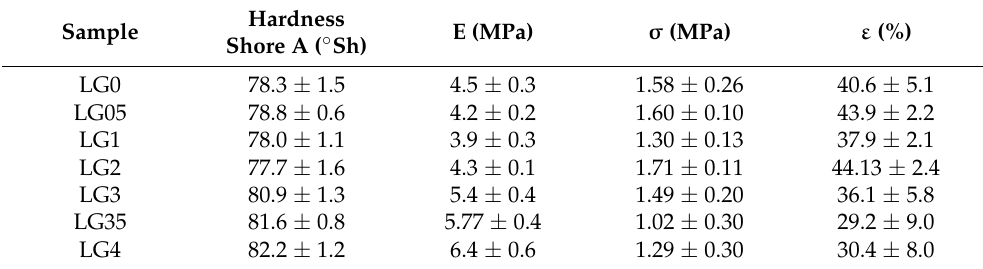
Table 3. Influence of lignin content on the mechanical properties of the printed films: Shore A hardness and tensile test parameters (E = Young’s modulus, σ = stress at break, and ε = elongation at